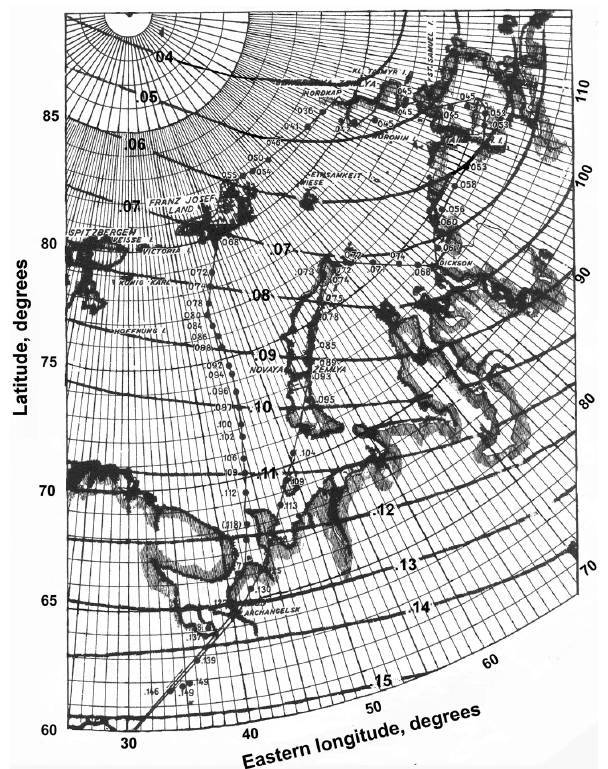
Figure 7. Map with the airship flight route showing results of measurements of H and isodynamic lines H from the chart of Fisk (1931) for the epoch 1930. The values of the H component are in mT.